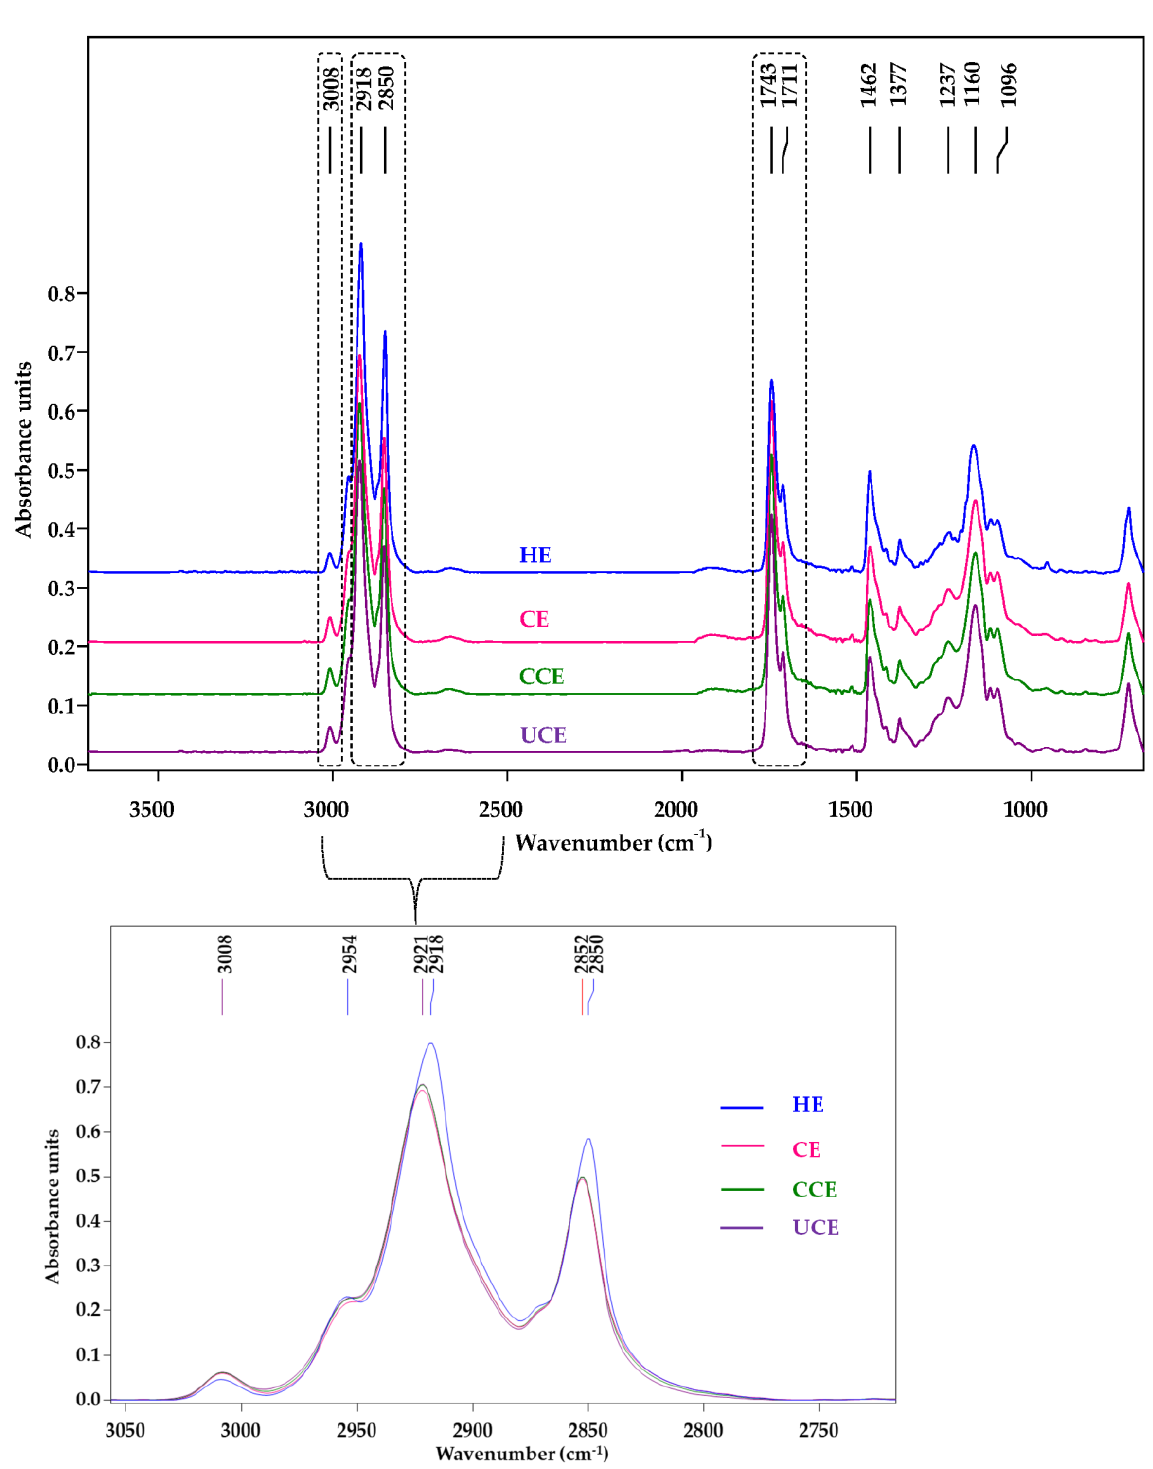
Figure 4. SR-FTIR spectra of CRBO from different extraction methods. HE: hexane extraction, CE: cold press extraction, CCE: thermally pretreated cold press extraction, UCE: ultrasound-pretreated cold press extraction.